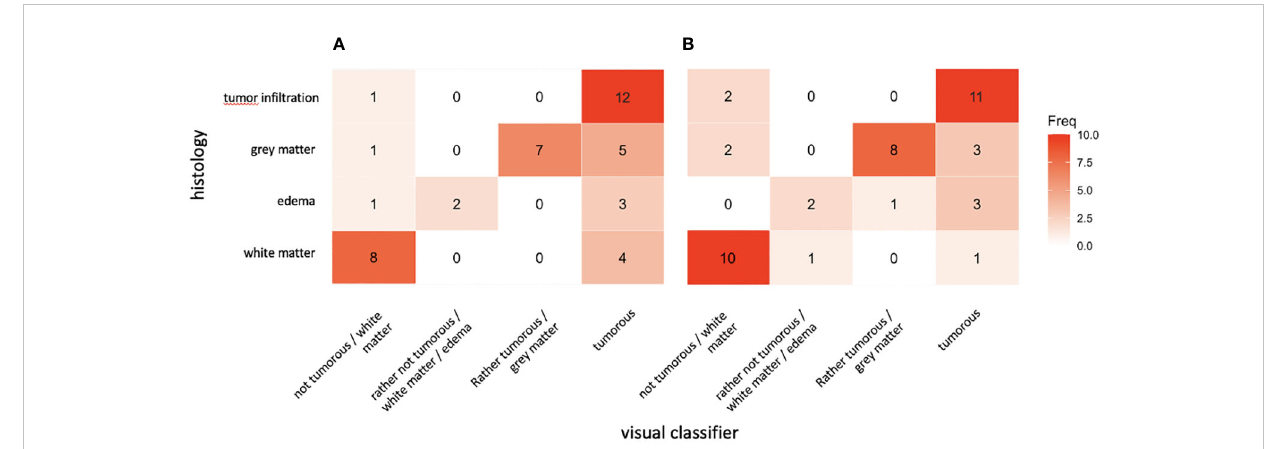
FIGURE 3 Heatmaps for degree of correlation between visual classi fi cation and histophatological fi nding for observer 1 (A) and observer 2 (B) from 44 subvolume scans.